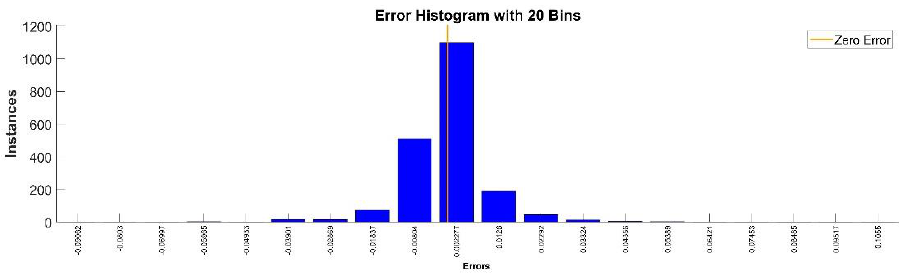
Figure 17. Relative errors between the target values and the predicted values for 𝑞 3 .